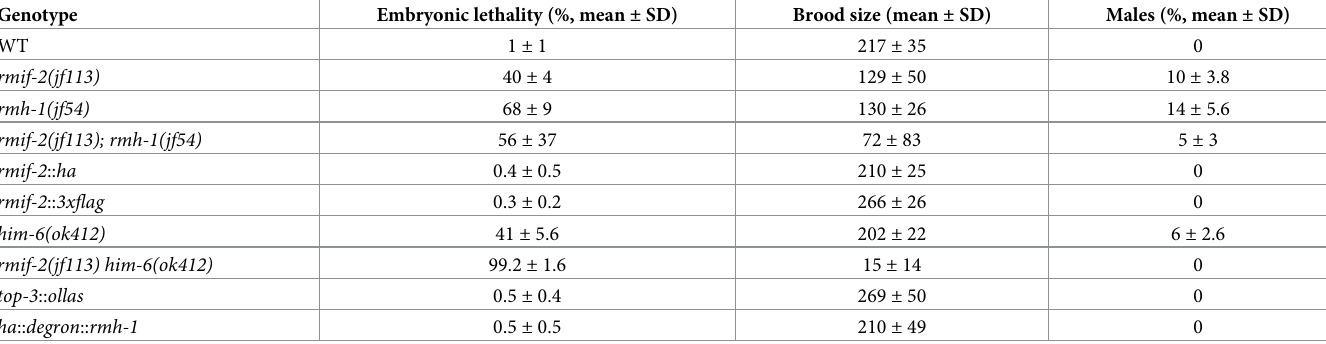
Table 2. Offspring analysis including embryonic lethality, brood size and segregation of male progeny in the genotypes used in this study. Genotype Embryonic lethality (%, mean ± SD)